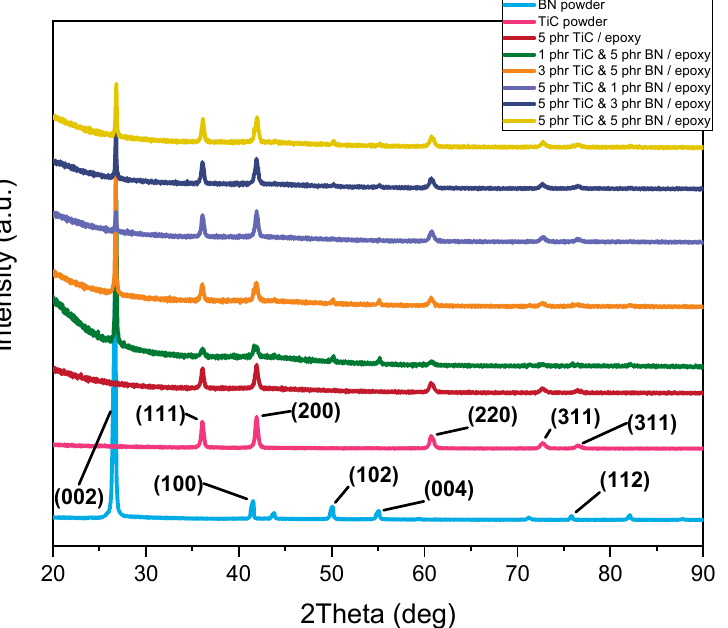
Figure 3. XRD patterns of studied hybrid composites and the employed fillers at room temperature.